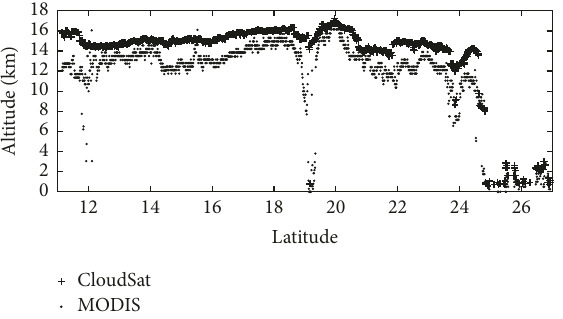
Figure 14: MODIS and CloudSat/CALIPSO CTH retrieval product of TC Bill .